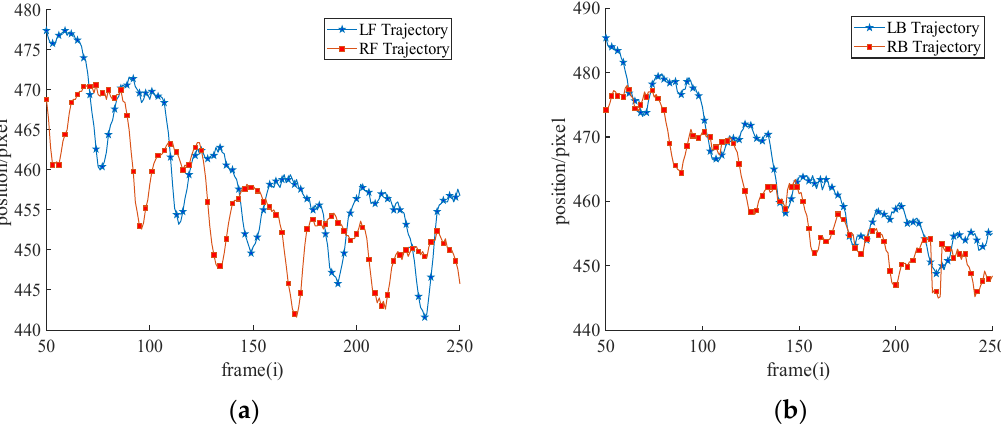
Figure 21. ( a ) Foot trajectory of buffalo’s forelimbs; ( b ) foot trajectory of buffalo’s hindlimbs.